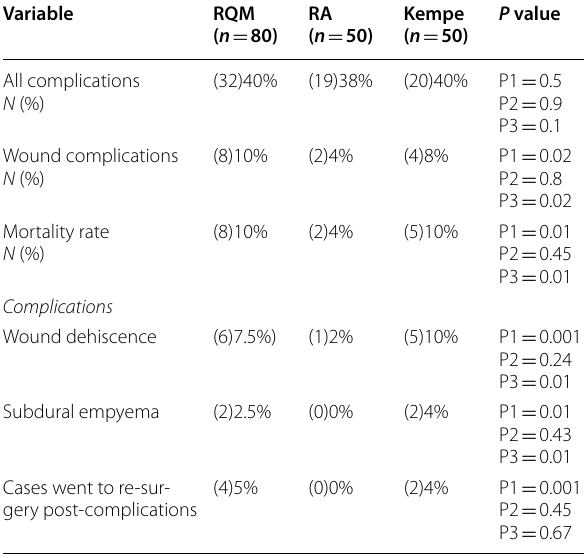
Table 3 Mortality rates and post-operative